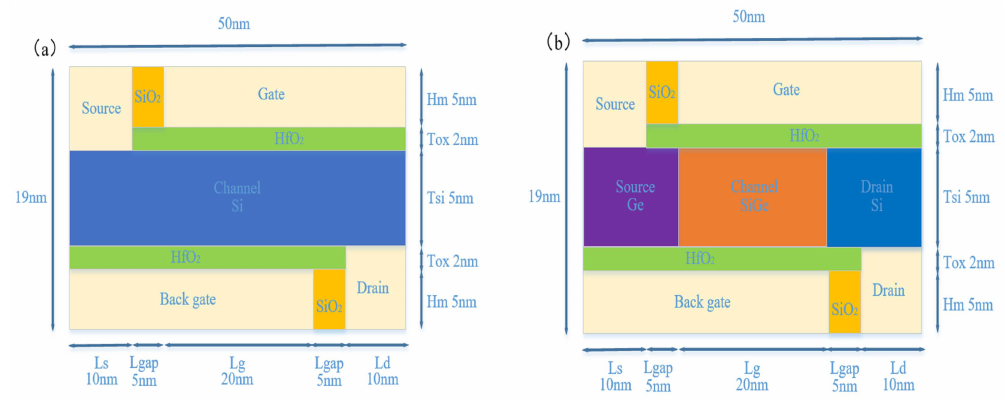
Figure 1. The schematic of ( a ) conventional DLTFET, ( b ) new proposed H-DLTFET.